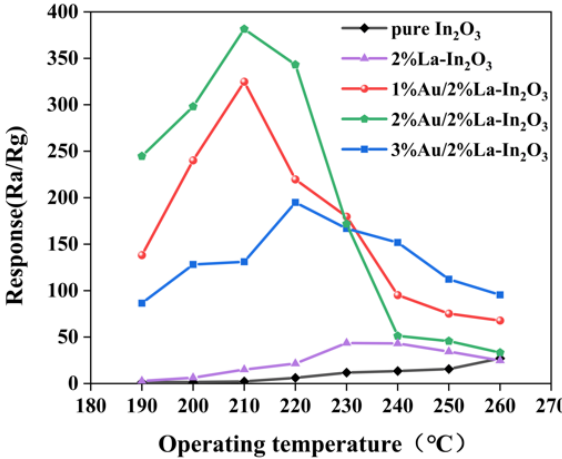
Figure 3. Response of In 2 O 3 doped with different Au and La content to 100 ppm ethanol at 190–260 °C.